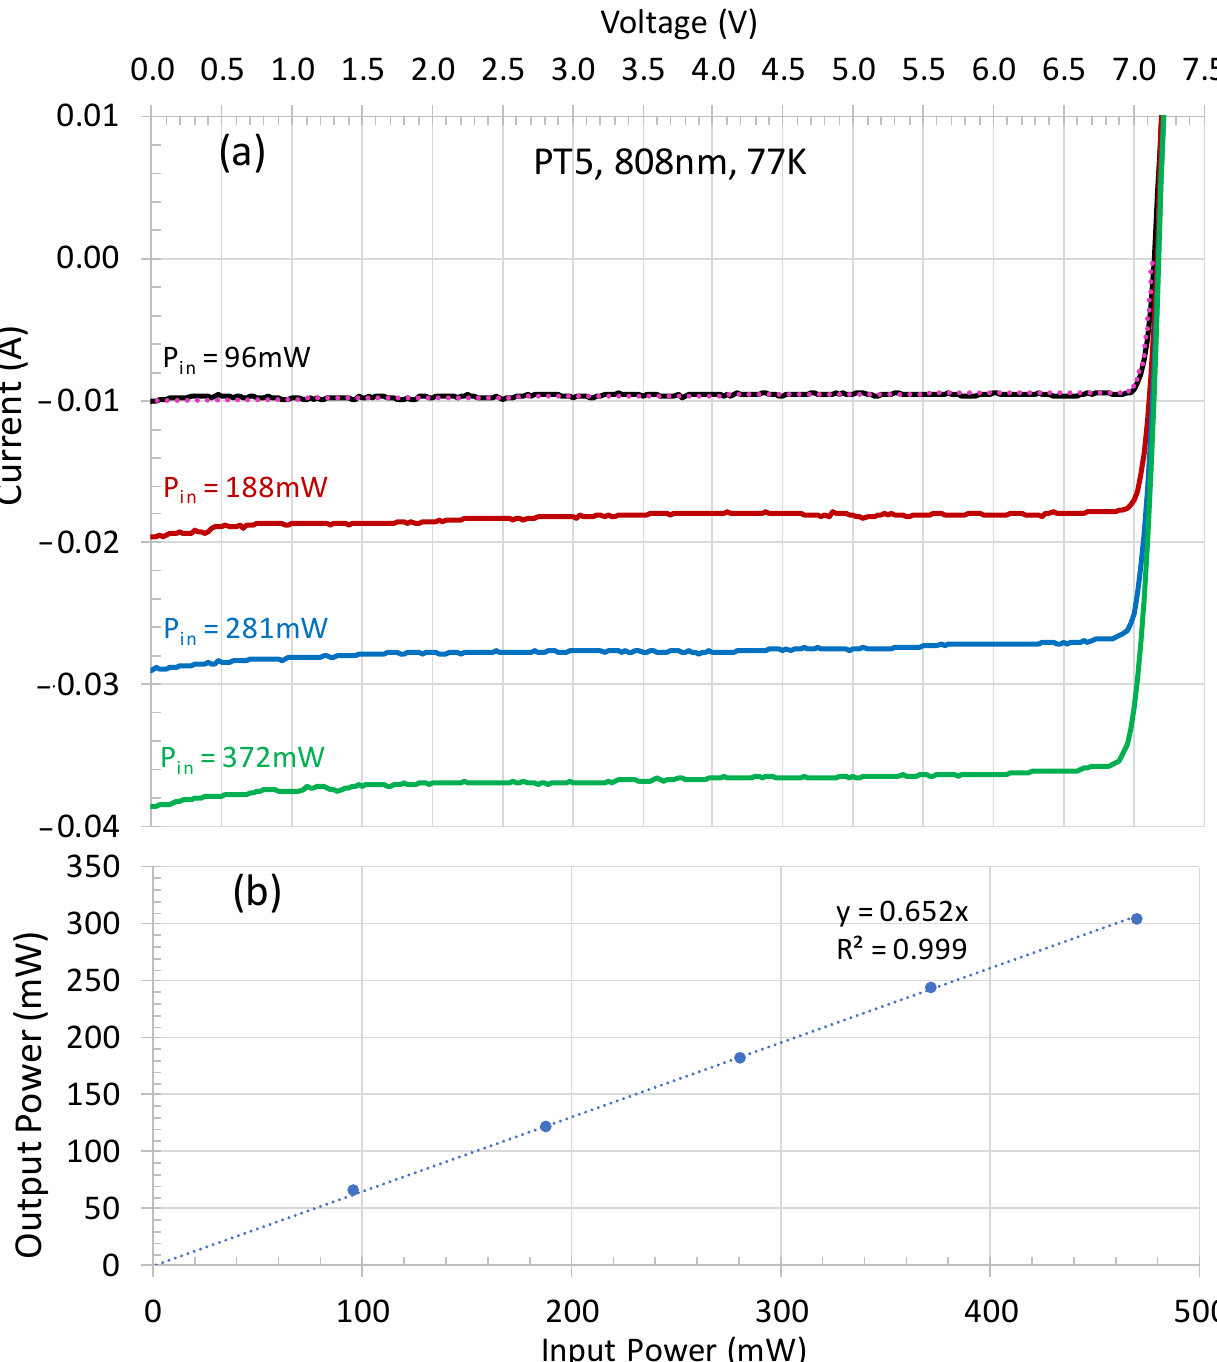
voltage offset value of W oc = 0.071 V, where W oc = (Eg/q) − V oc with Eg being the bandgap energy (here, 1.508 eV for GaAs at 77 K) and q is the electronic charge. The W oc values obtained with the PT5 at low temperatures are therefore significantly better than the best values obtained at room temperature for GaAs with W oc (20 ◦ C) = 0.181 V [41], and also for the long wavelength PT10-InGaAs/InP OPCs with W oc (20 ◦ C) = 0.187 V [47].